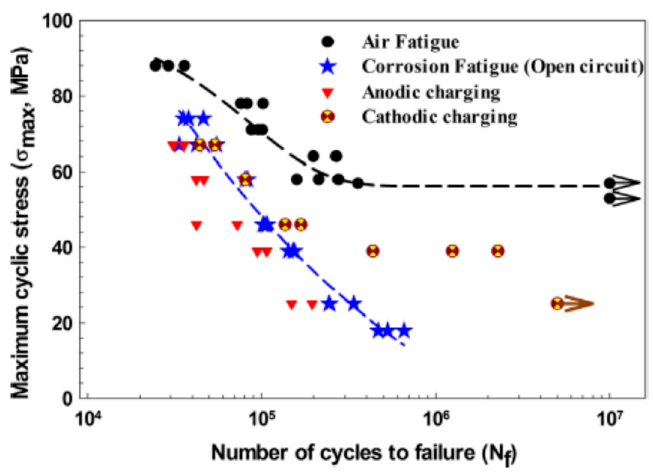
Figure 13. S-N curve for AZ91D magnesium alloy under different electrochemical conditions. Reproduced with permission from [86], Copyright Elsevier, 2015.